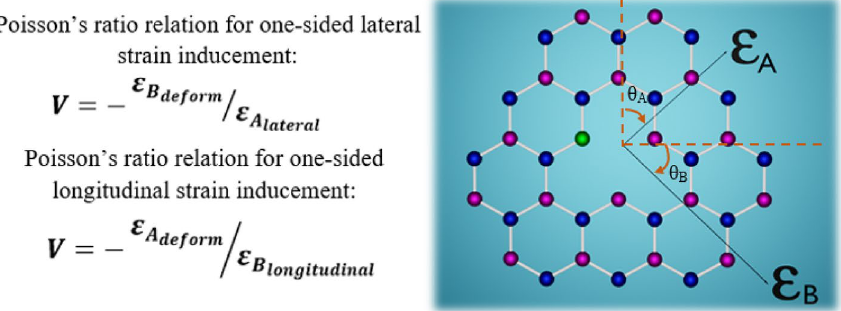
Figure 7. Poisson’s ratio relations and corresponding orthogonal strain directions. According to Poisson’s ratio, as shown in Fig. 3, when tensile (stretching) effect is induced in both sides of lateral (vertical) direction, then the compressive (shrinking) deformation takes place in both the sides longitudinal (horizontal) direction (which is orthogonal) and vice-versa. But, for one-sided lateral or longitudinal strain inducement, the strain is induced in one edge of vertical or horizontal directions respectively, by fixing another edge and so that the deformation due to Poisson’s ratio will also be only one side (which can be orthogonal). Now, for the 2D hBN with point defect (C B V N ), inducing one-sided lateral strain means inducing strain towards Ɛ A direction (whose direction is almost vertical, with a small tilt of θ A ) and due to Poisson’s ratio, along with actual lateral strain, a small deformation will also occur at orthogonal position i.e., Ɛ B direction (whose direction is orthogonal to Ɛ A ). The amount of deformation can be known by the expression (Poisson’s ratio relation for one-sided lateral strain